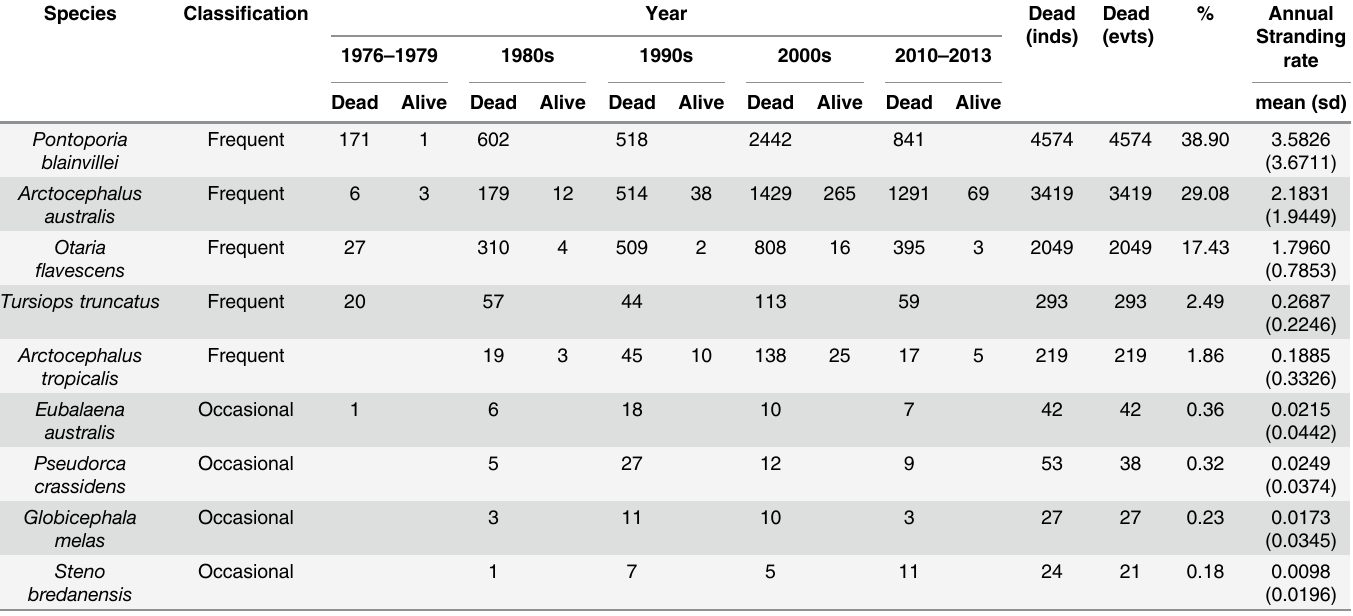
Table 2. The number of individual (inds) marine mammal strandings observed from 12,540 reported events (evts) in southern Brazil from 1976 to 2013. The total stranding events for each species is given as number and as percentage. Mean annual stranding rates are shown in the last column. Species Classi fi